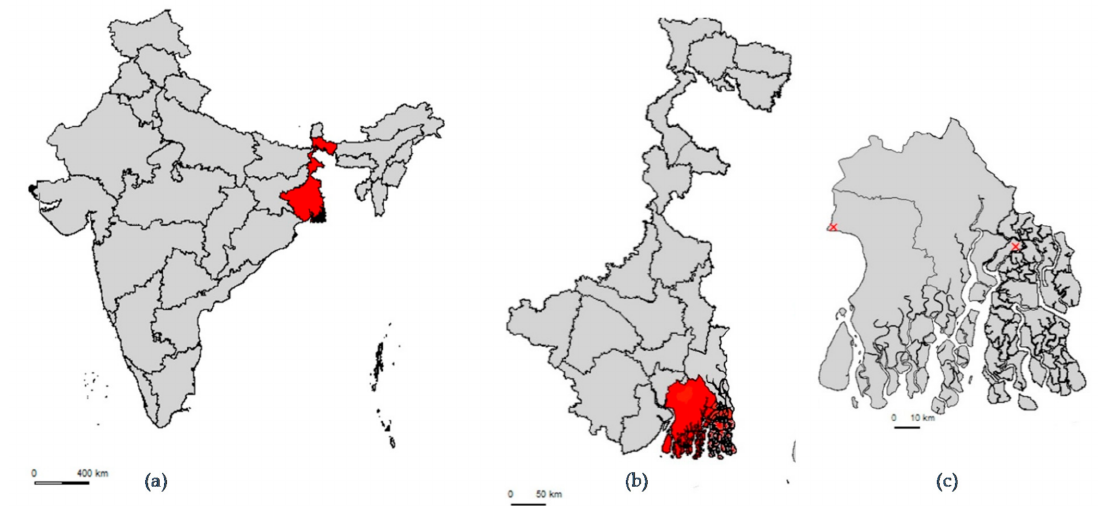
Figure 1. ( a ) Map of India highlighting West Bengal. ( b ) Map of West Bengal highlighting South 24 Parganas. ( c ) Map of South 24 Parganas marking Site 1 (West) and Site 2